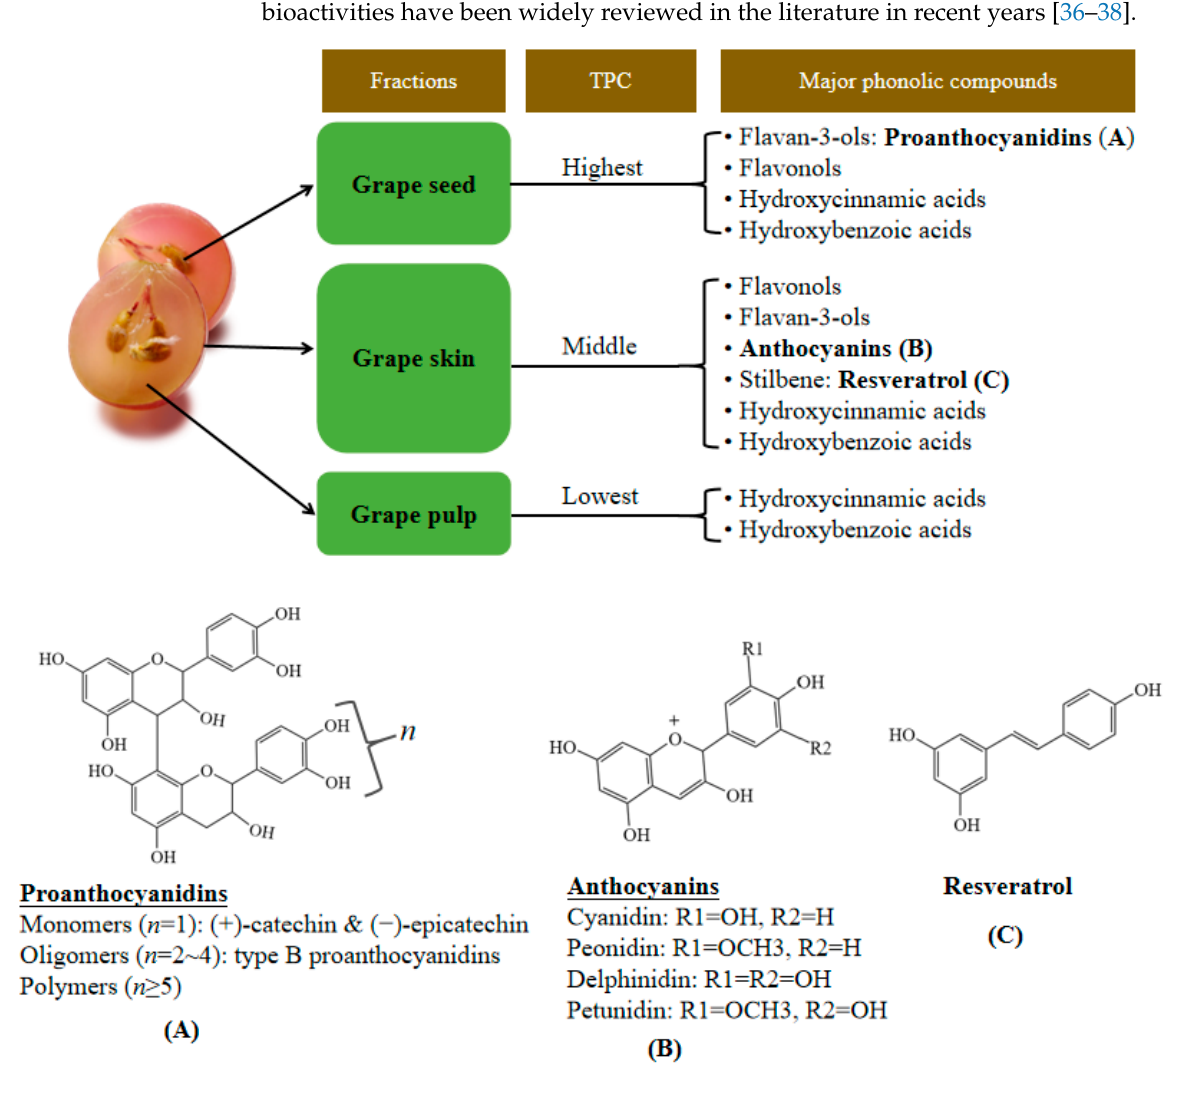
Figure 1. Phenolic compounds in different fractions of grape and the chemical structures of several representative bioactive compounds. ( A ) Proanthocyanidins; ( B ) anthocyanins; ( C ) resveratrol. TPC, total phenolic content. Table 1. The 78 phenolic compounds in grape pulp samples